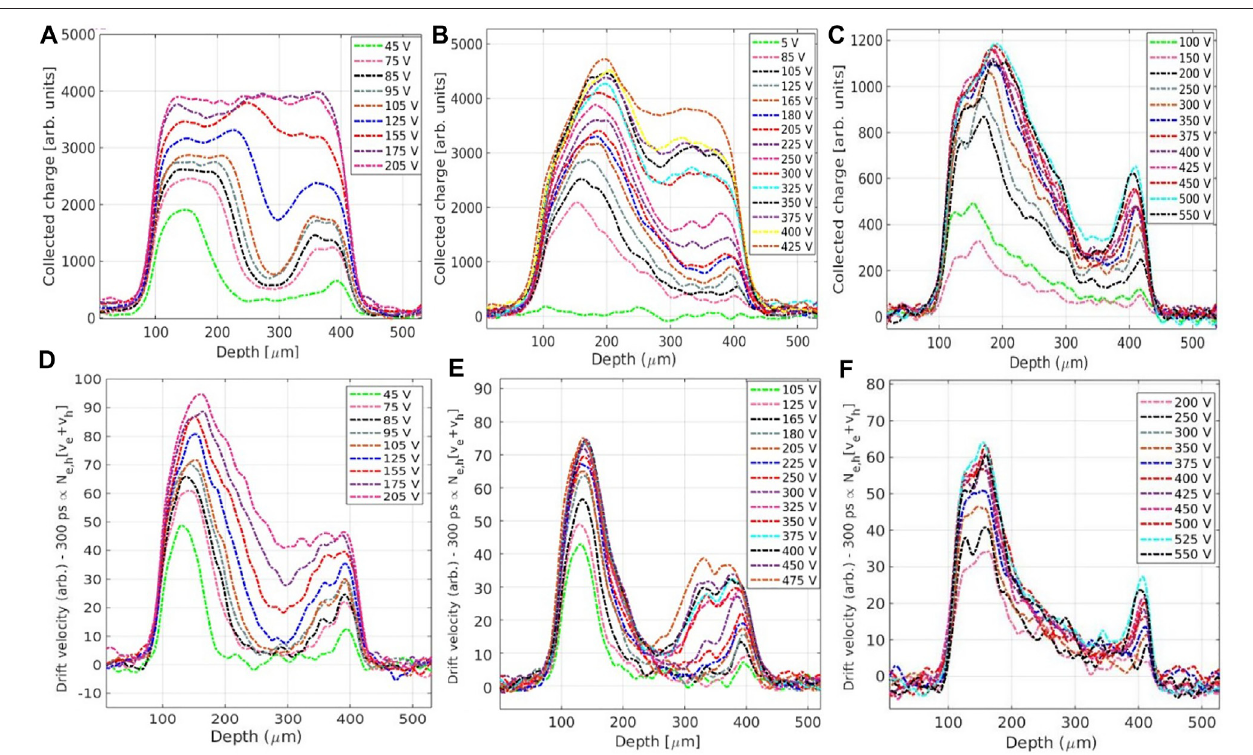
FIGURE 14 | Measured charge collection pro fi les at varying bias voltages for AC-coupled pixel sensor irradiated to a fl uence of: (A) 10 14 protons/cm 2 , (B) 3 × 10 14 protons/cm 2 , and (C) 10 15 protons/cm 2 , at a temperature of − 15 ° C. (D – F) Electric fi eld pro fi les for the AC-coupled pixel sensors irradiated with the same fl uences, respectively.